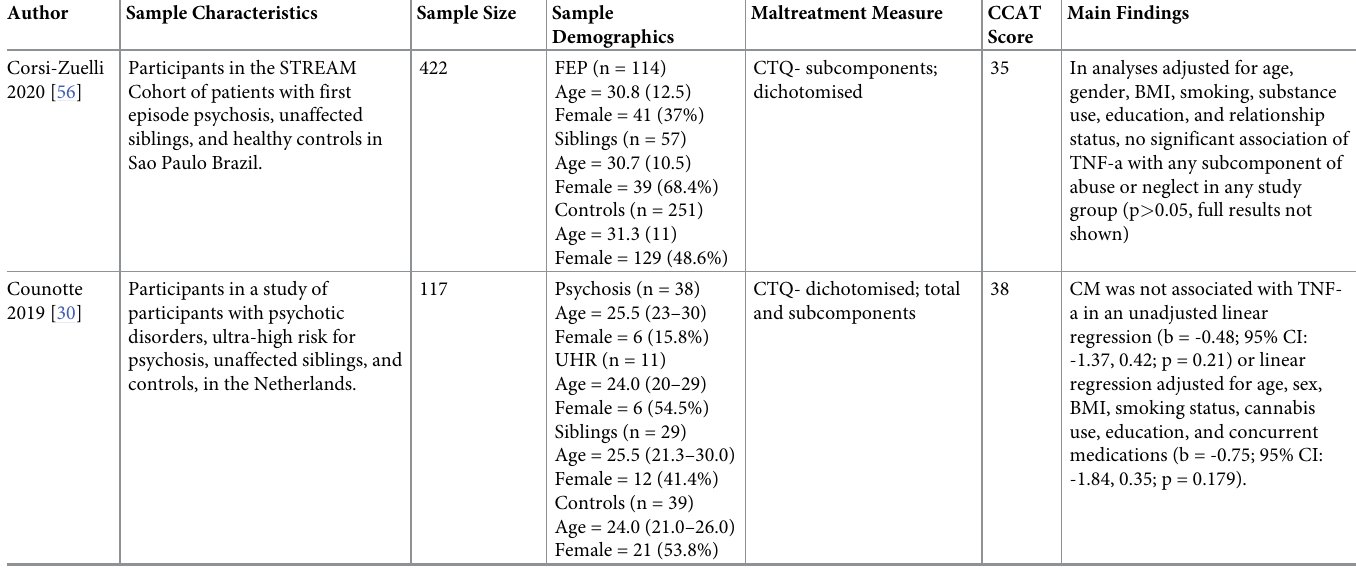
Table 4. a- Studies reporting TNF-a: Clinical populations. b- Studies reporting TNF-a: Non-clinical